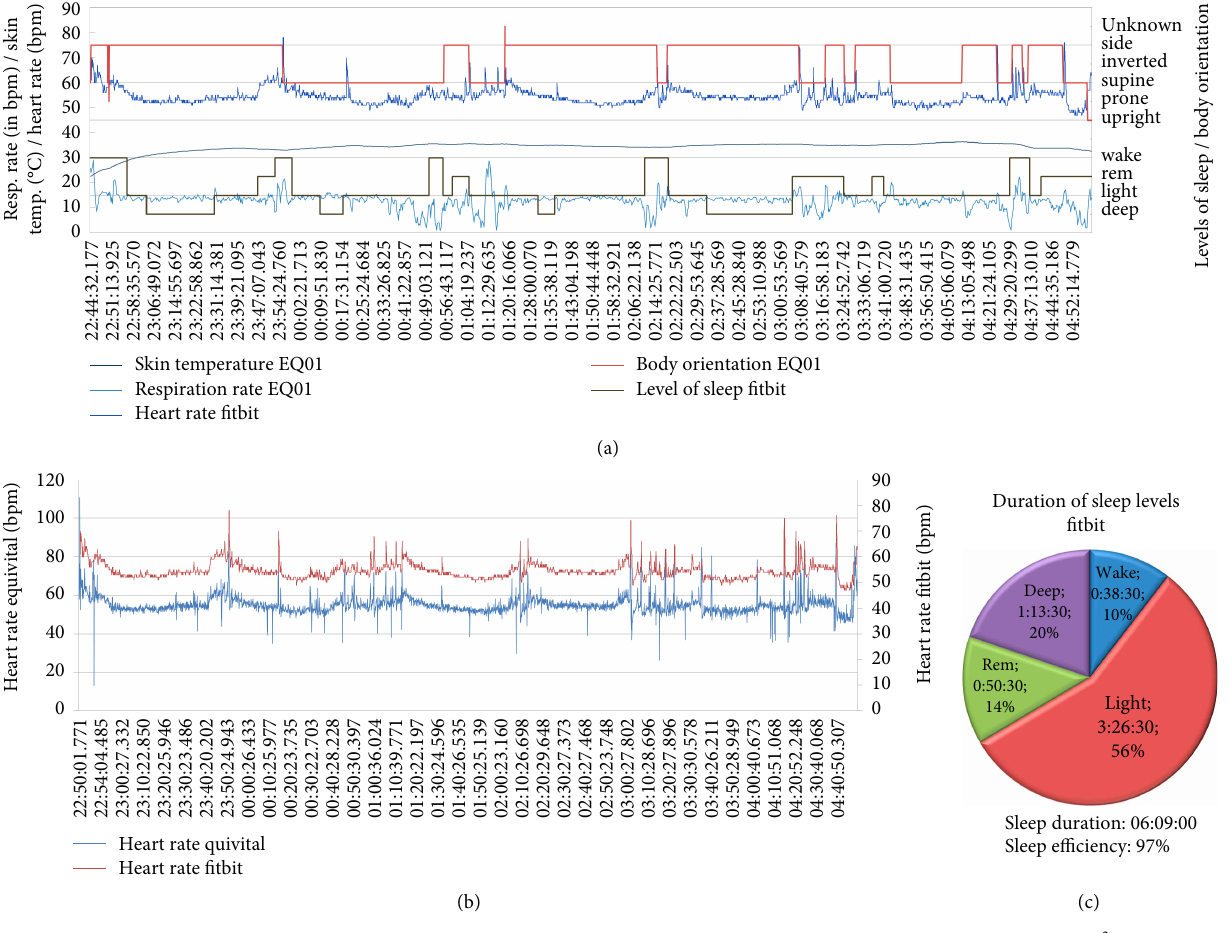
Figure 9: Individual data sets of one subject (1) for overnight monitoring: (a) prepared time-based data for the transfer to the p 2 Health-Cloud ; (b) comparison of the heart rate from both sensor devices; (c) prepared statistical data for the transfer to the p 2